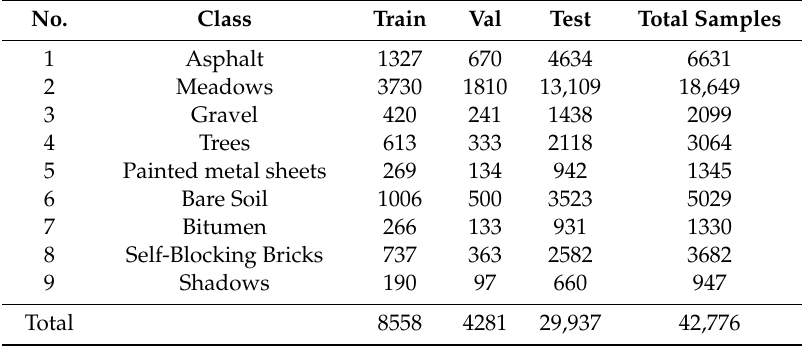
Table 5. The number of training, validation, test, and total samples in the UP dataset.